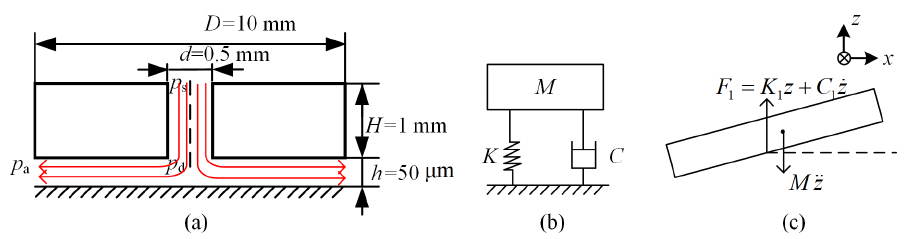
Figure 1. Orifice-type and its equivalent model: ( a ) axial section of the restrictor; ( b ) equivalent spring model; and ( c ) one-orifice